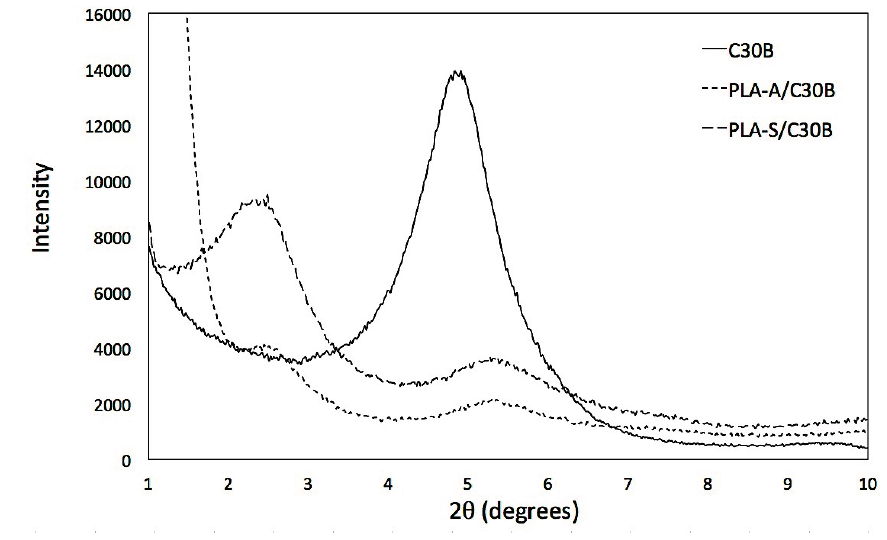
Figure 2. XRD of PLA nanocomposites and organic modified MMT (C30B) used as